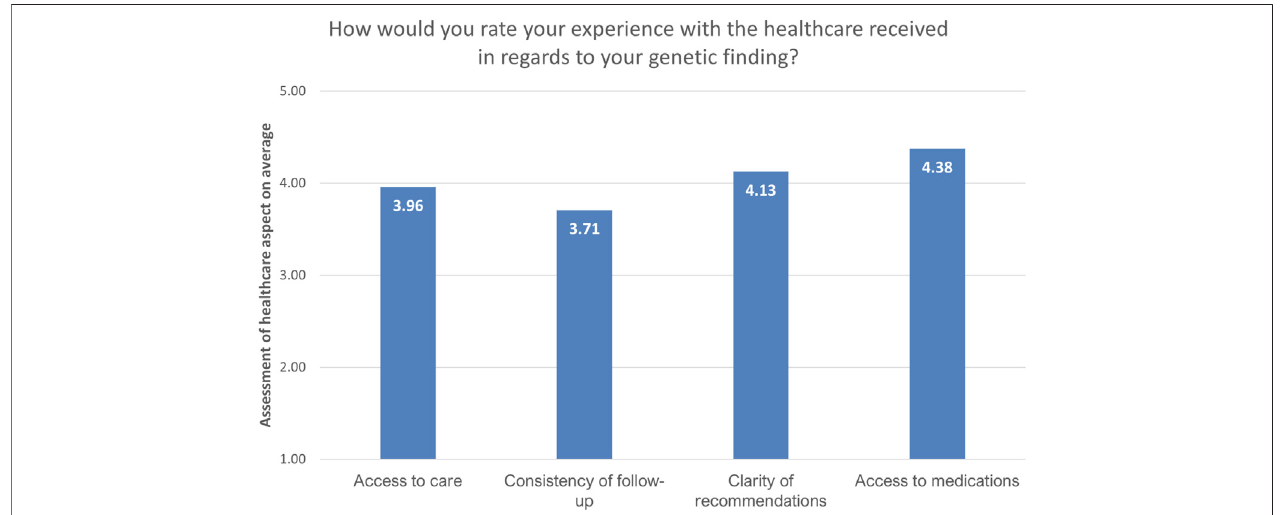
FIGURE 4 | Overview of the assessment of the current state of the healthcare system by recalled participants ( n = 24). The answers are presented as mean values ofprovidedanswersconvertedtonumericvalues: “ verygood ” -5, “ good ” -4, “ unsure ” -3, “ satisfactory ” -2, “ unsatisfactory ” -1.Meanvaluesabovethreesignifysatisfaction with the speci fi c healthcare aspect.